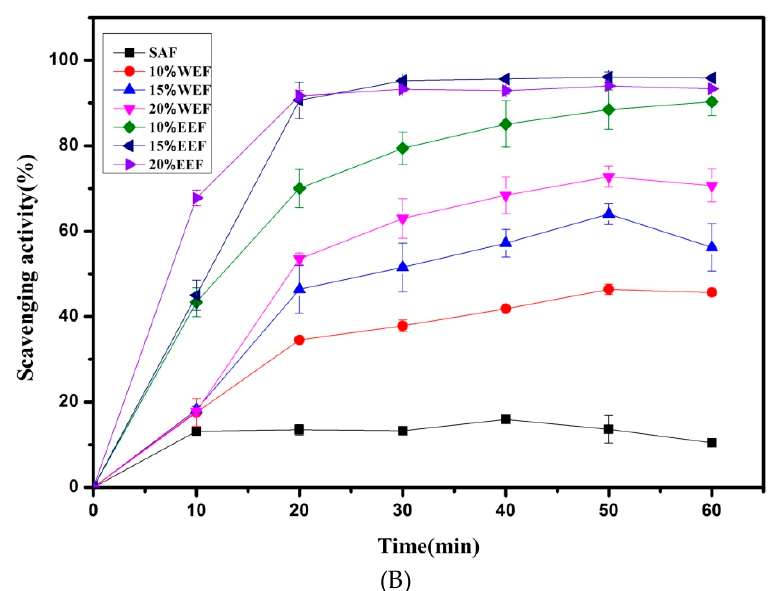
Figure 5. Weight-dependent ( A ) and time-dependent ( B ) DPPH radical scavenging ability of the films.